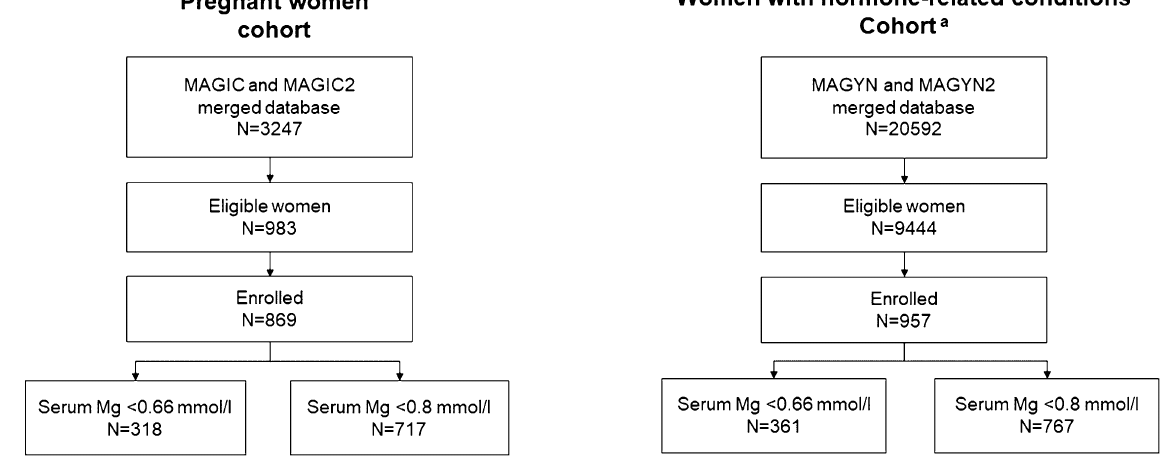
Figure 2. Study population. a Severe HME (n = 50) cases were excluded from subgroup analysis of women with hormone-related conditions cohort. Mg